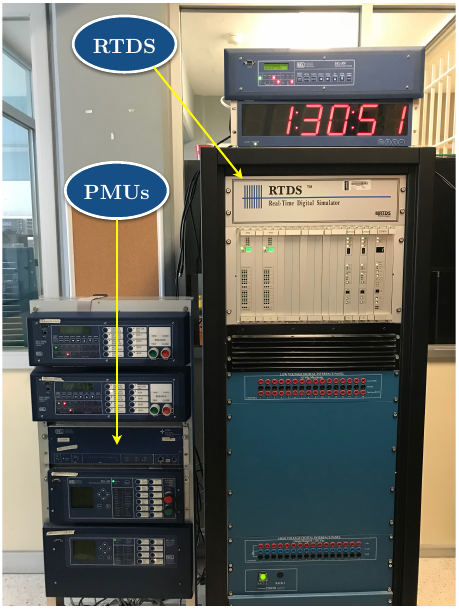
Figure 3. Hardware-in-the-loop implementation in